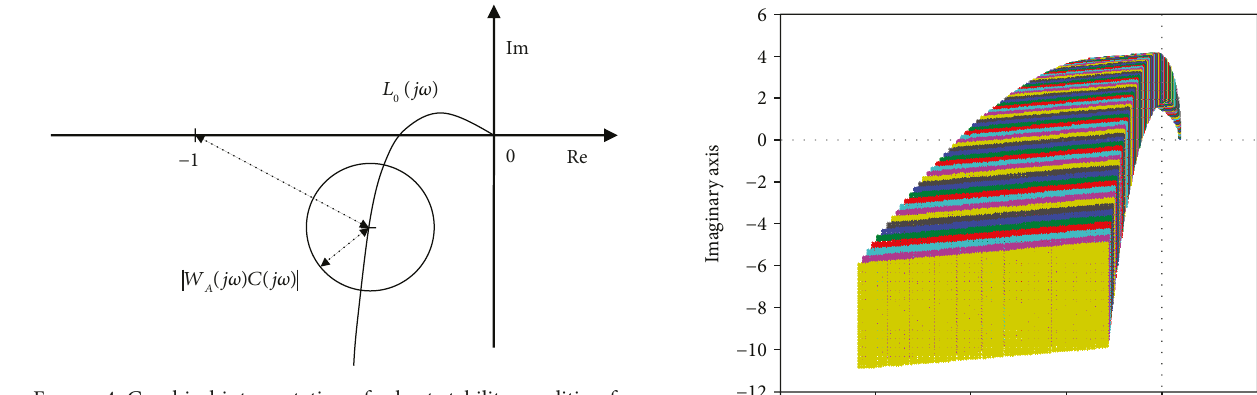
Figure 4: Graphical interpretation of robust stability condition for additive uncertainty.